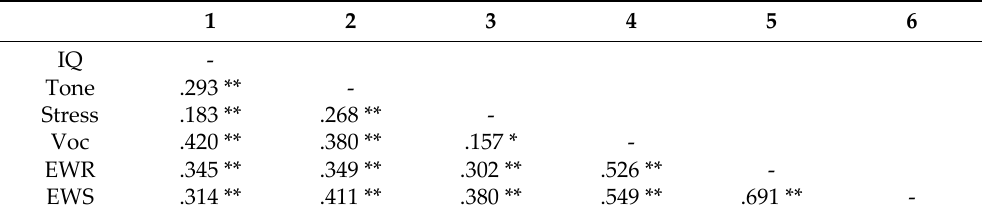
Table 2. Bivariate Correlations between IQ, Tone, Stress, Oral vocabulary and Word‑level Literacy.